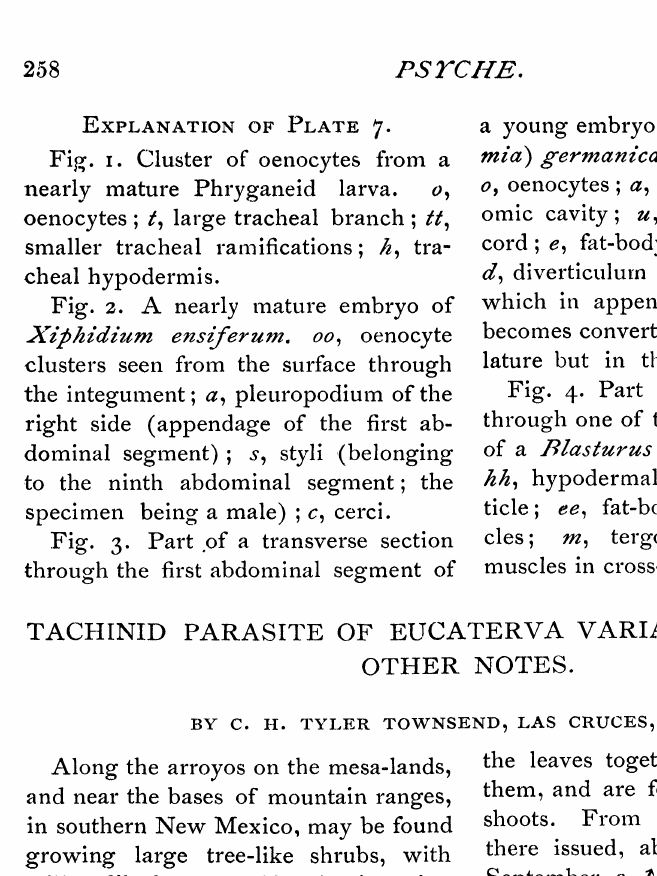
Fig. I. Cluster of oenocytes from a nearly mature Phryganeid larva. oenocytes l, large tracheal branch; smaller tracheal ramifications; h, tra- cheal